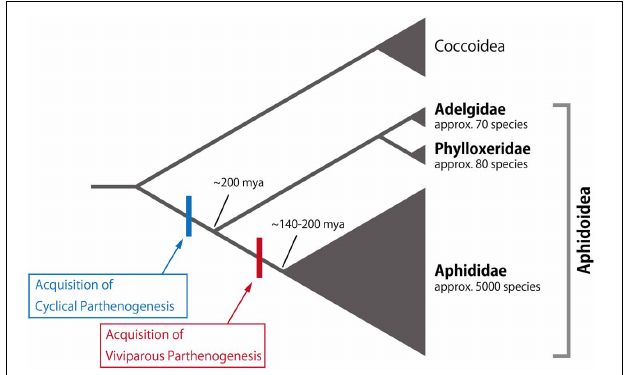
FIGURE 2 | Phylogeny of aphids and sister groups. Cyclical parthenogenesis and viviparity are serially acquired in the Aphidoidea lineage. Extant species numbers in the families are indicated below each family name. Considerable diversification is seen in Aphididae, showing both of cyclical parthenogenesis and viviparity. The phylogeny and extant species numbers are based on Davis (2012) and Aphid Species File (Version 5.0/5.0, http://aphid . speciesfile . org/ ),